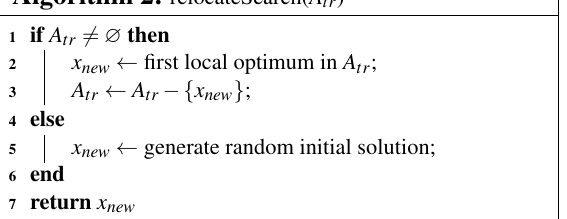
Algorithm 2: relocateSearch( A